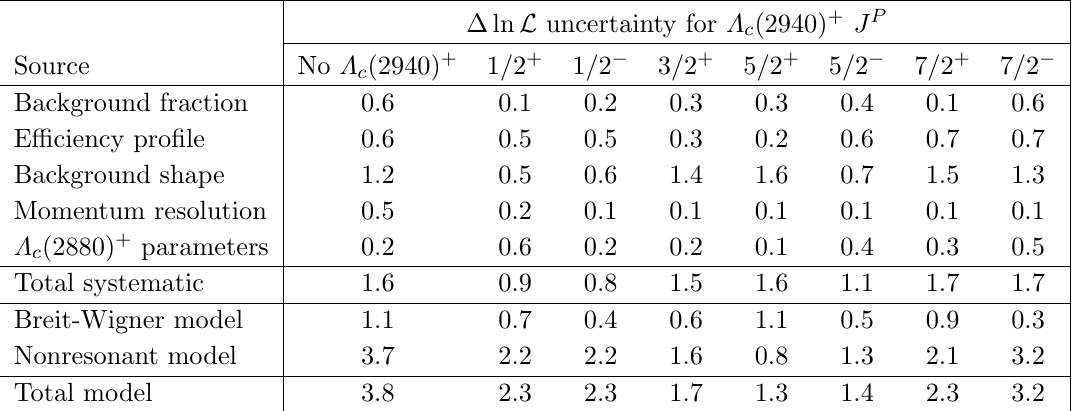
Table 11 . Systematic and model uncertainties on (cid:1) ln L between the baseline (cid:12)t with J P = 3 = 2 (cid:0) for the (cid:3) c (2940) + state and other (cid:12)ts without a (cid:3) c (2940) + contribution or with other spin-parity assignments, for the polynomial nonresonant